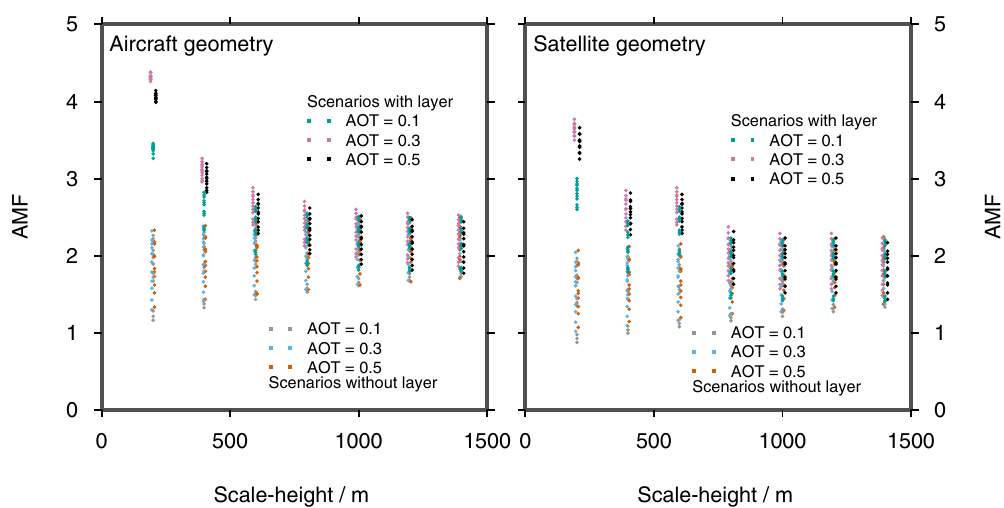
Figure 8. Air-mass factors at SZA = 55 ◦ for scenarios based on an exponentially decreasing vertical profile of NO 2 and aerosols, with scale heights varied from 1400 to 200m. These profiles are based on scenarios 11 and 12 from Fig. 4. Profiles with an elevated layer display an increasing trend of AMF with decreasing scale height; those without the layer show a decrease in AMF. Table 2. Cases of background, urban, and plume measurements identified from the iDOAS measurements on 9 August 2007. Aircraft time is given in UTC. OMI nadir refers to the TVCD value in the OMI pixel at aircraft nadir. Similarly, OMI east and OMI west refer to the OMI pixel one row east and west of aircraft nadir respectively. iDOAS peak refers to the peak VCD within the OMI pixel at aircraft nadir. iDOAS average is the line-averaged iDOAS measurements within the OMI pixel at aircraft nadir, and iDOAS standard deviation is the iDOAS-measured variability within this OMI pixel expressed as a standard deviation. iDOAS CV is the coefficient of variation (or relative standard deviation) of the measured variability. All column densities are expressed in petamoleccm − 2